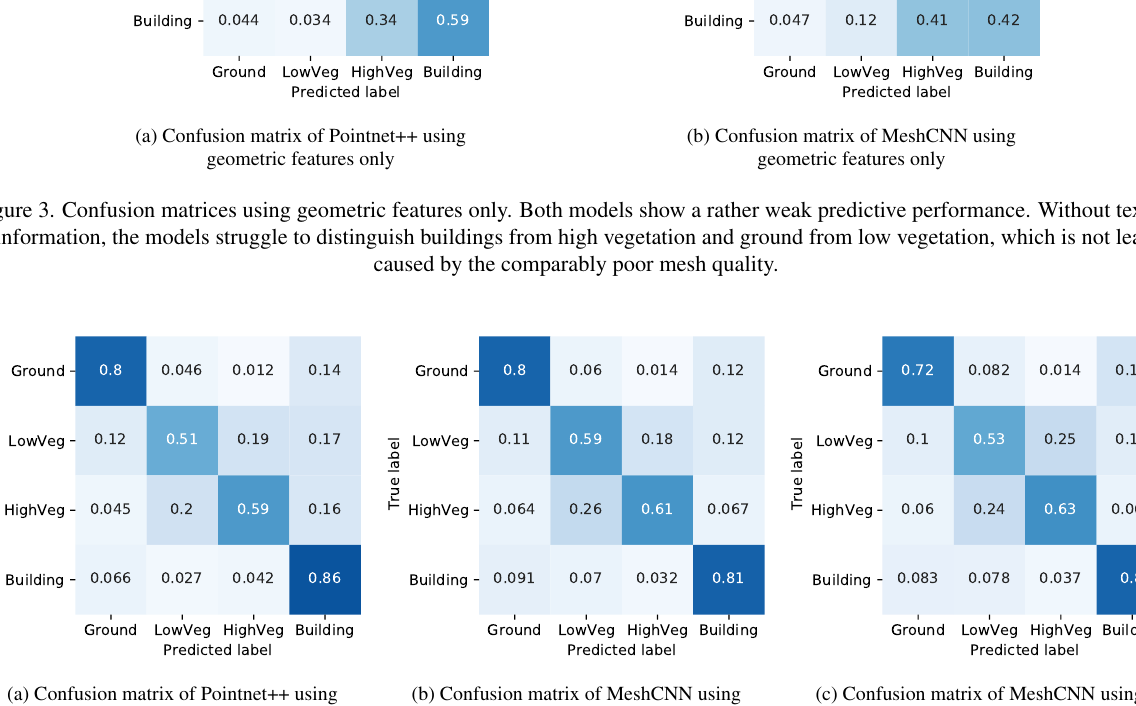
(c) Confusion matrix of MeshCNN using photometric features only Figure 4. Confusion matrices with inclusion of photometric features. Both models show a similar predictive performance when geometric and photometric features are used together ( a and b ). The two vegetation classes are confused with each other the most. There might be two reasons: 1) In some cases it might be hard to draw the line between the two classes during annotation; 2) Photometric features are obviously dominating geometric ones in this setup. An evaluation of MeshCNN with color features only ( c ) supports the second argument and also shows that geometric features at least have some impact as the vegetation classes do get confused more often without them.